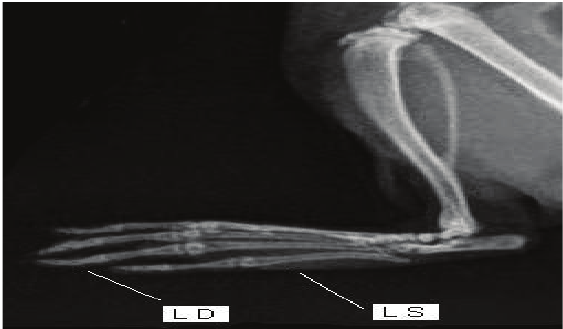
Fig-4: Prophylactic Group 4 Anthraquinone 250mg/kg treated rats shows low swelling (LS) of hind paw and low deformity (LD) of interphalamgeal joints.